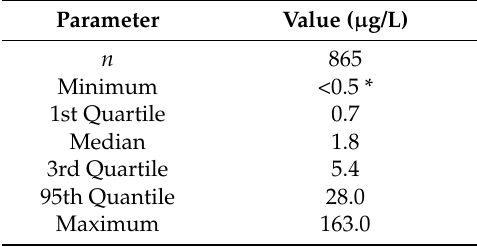
Table 1. Summary of urine values ( µ